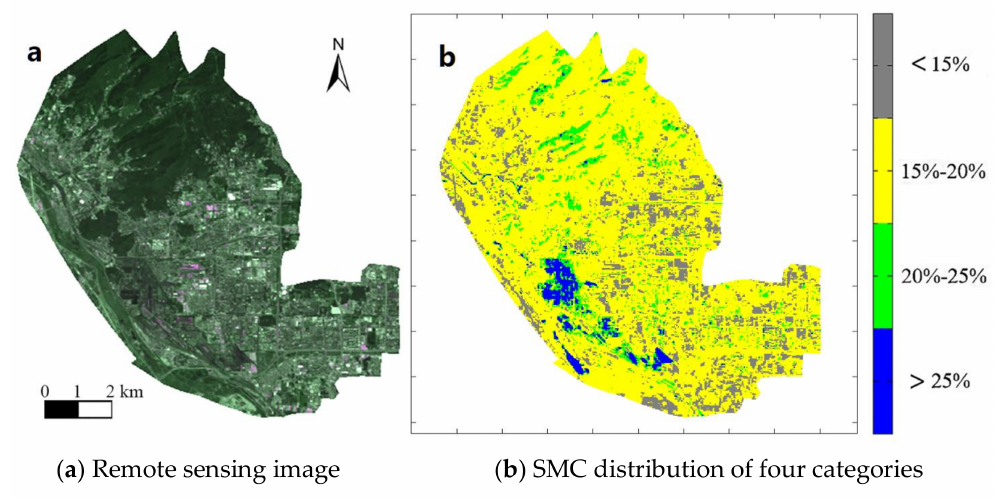
Figure 12. The remote sensing image and SMC distribution in the Shijingshan